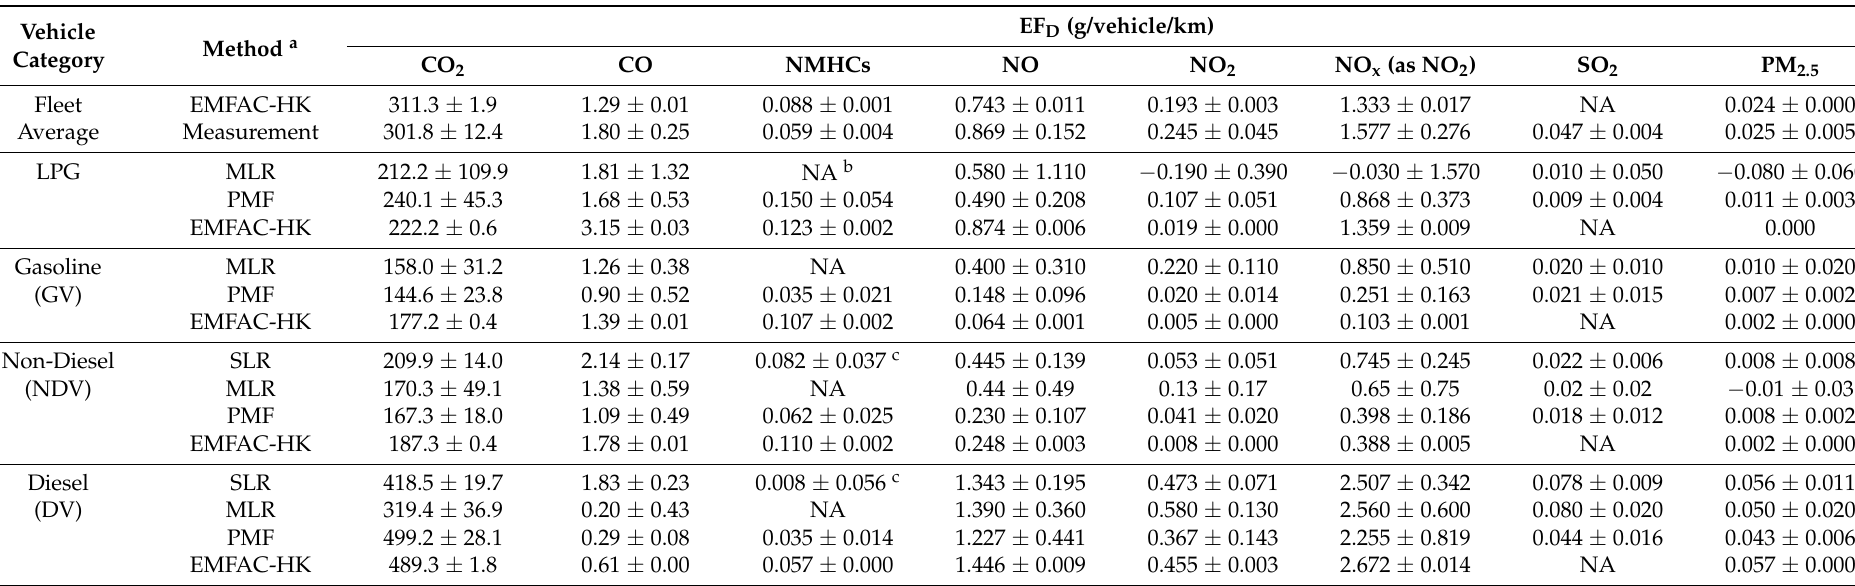
Table 1. Comparison of emission factors (EF D ; average ± expanded uncertainty at 95% confidence interval) for different fleet components from different